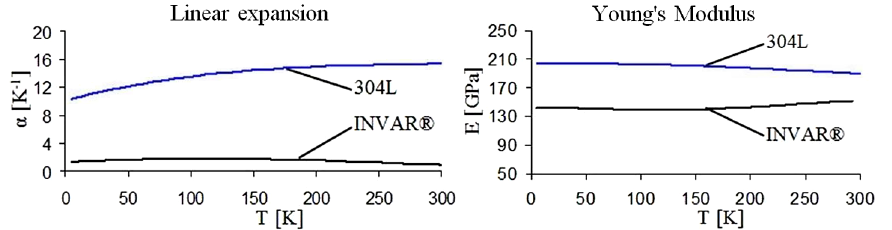
FIG. 5. Comparison of the properties of stainless steel 304L and Invar ® [9].